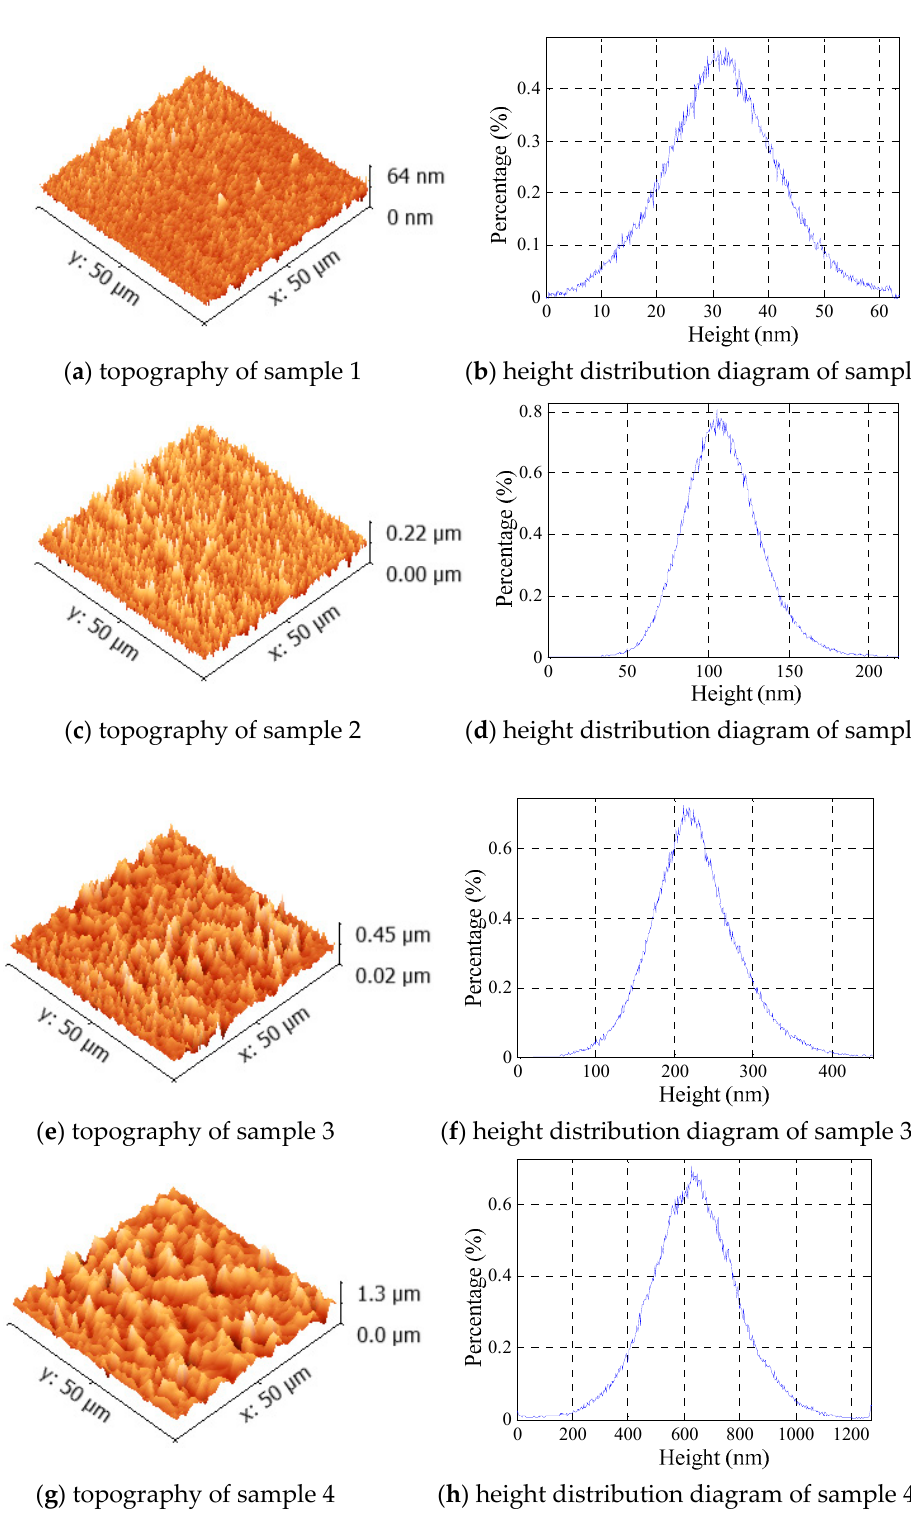
Figure 6. Morphology and height distribution diagram of each sample.